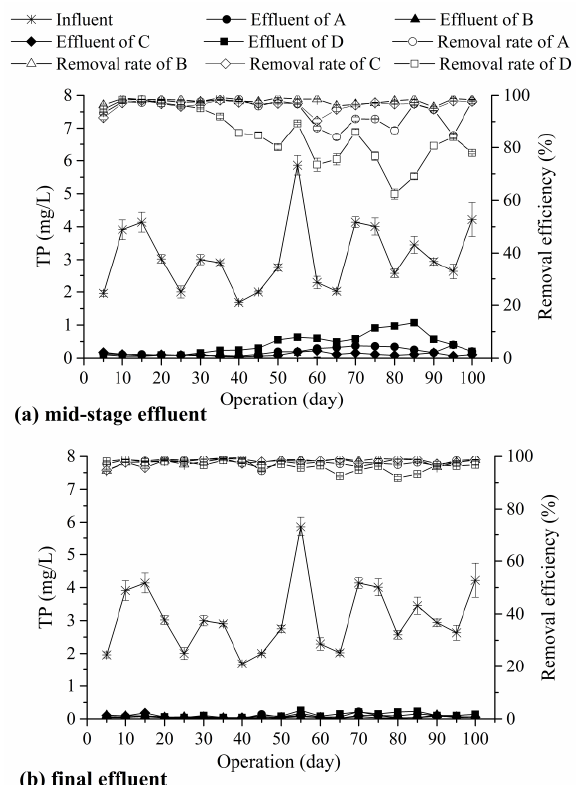
Figure 3. Concentrations of TP and removal efficiencies in different experimental MSL-SWI systems. ( a ): TP in mid-stage effluent; ( b ): TP in final effluent